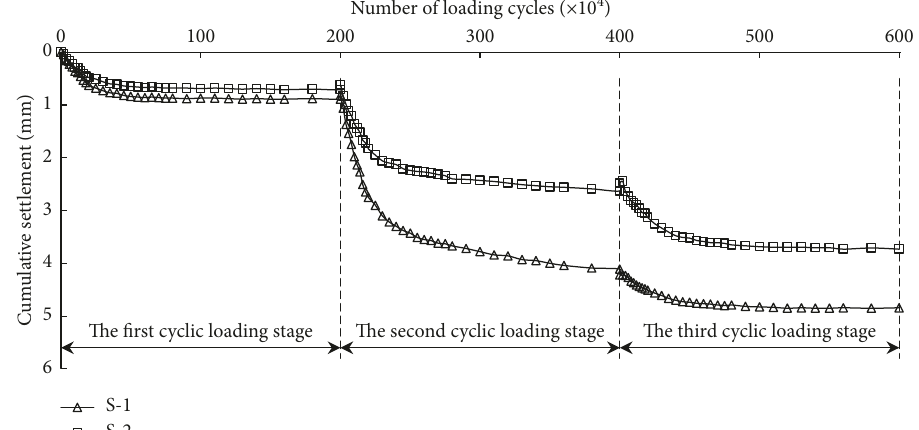
Figure 13: The variation of cumulative settlement of the subgrade bed with the number of loading